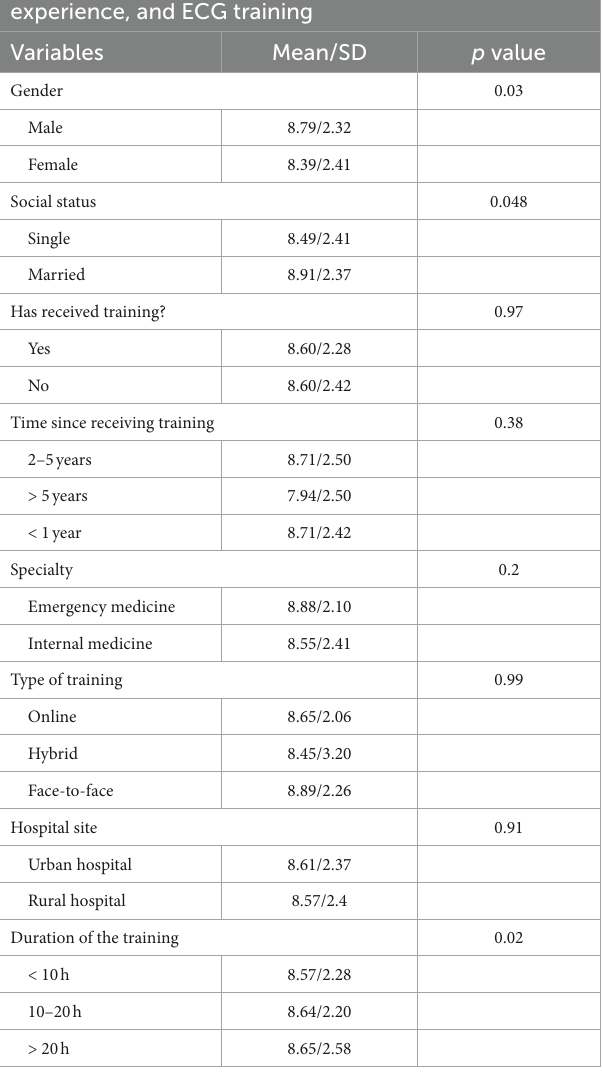
TABLE 3 Sample description of hospital, years of work experience, and ECG training. Sample description of hospital, years of work experience, and ECG